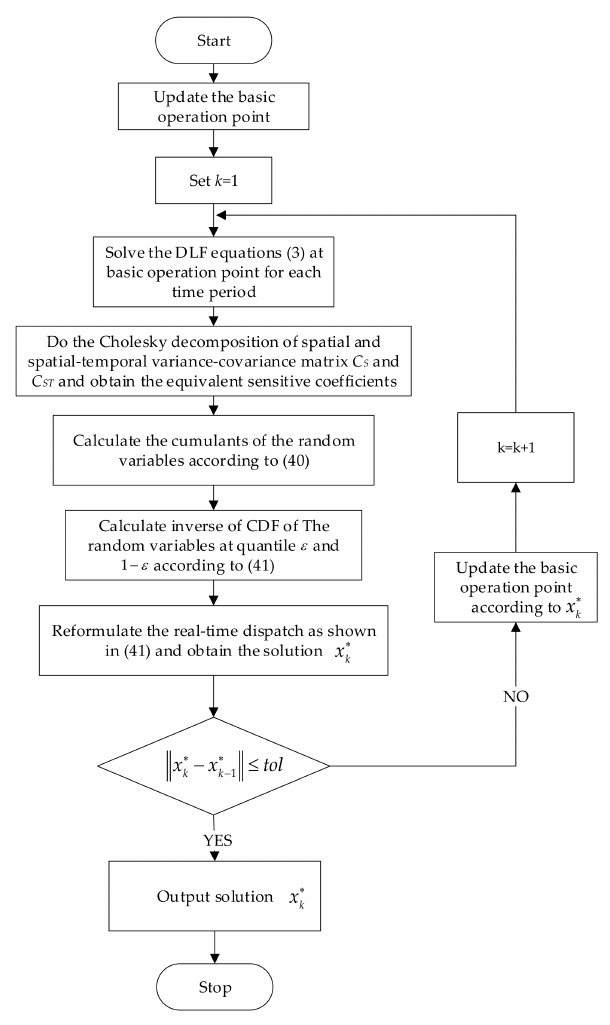
Figure 2. Flowchart of chance-constrained programming based on cumulants and Cornish-fisher expansions